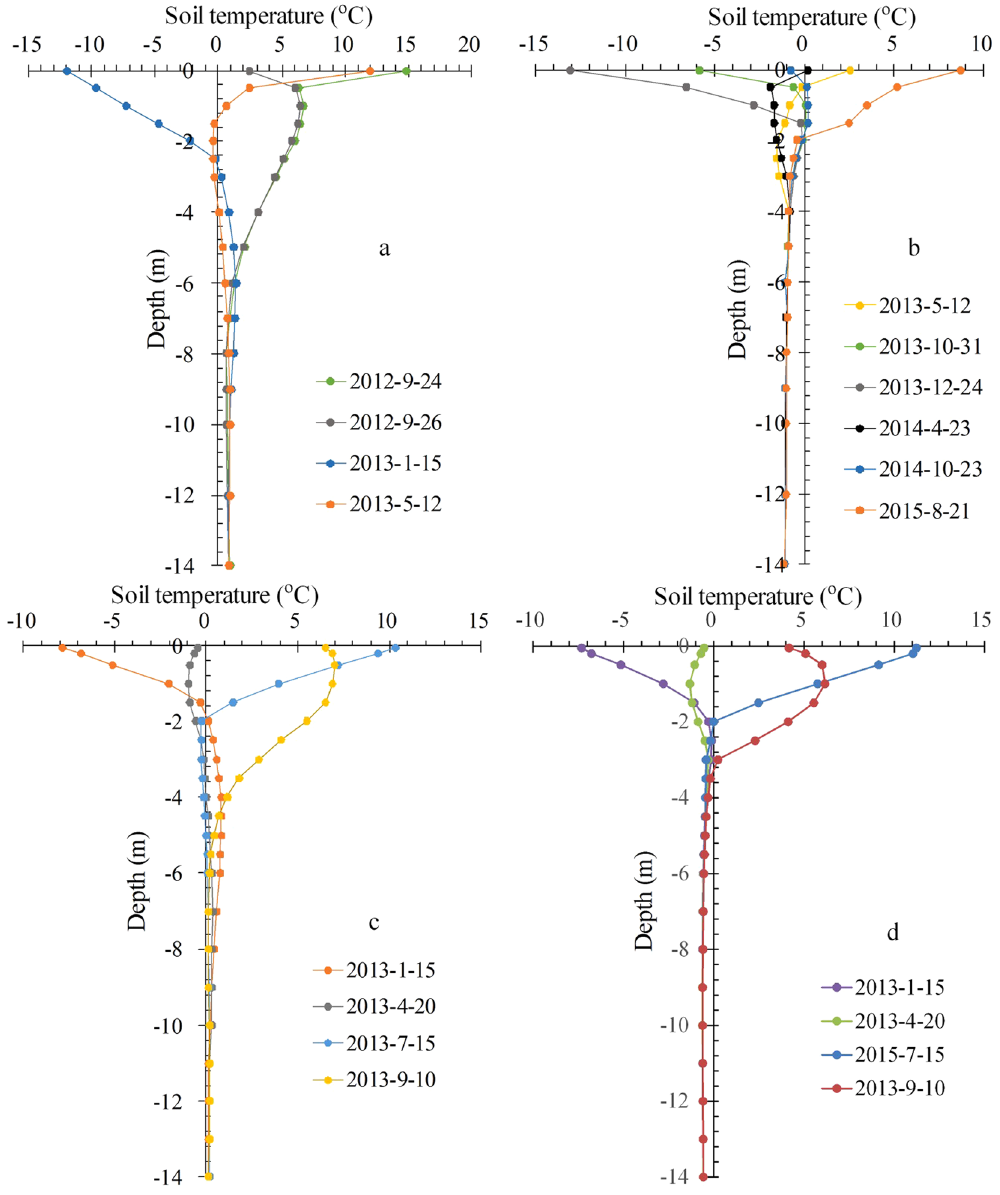
Figure 4. Soil temperature profiles at sites with ( a ) a 3.0-m-thick sand cover (Yu-4), ( b ) desertified land with sparse vegetation (Yu-6), ( c ) a 30-cm-thick sand cover (QH-4), and 1.15-m-thick sand cover